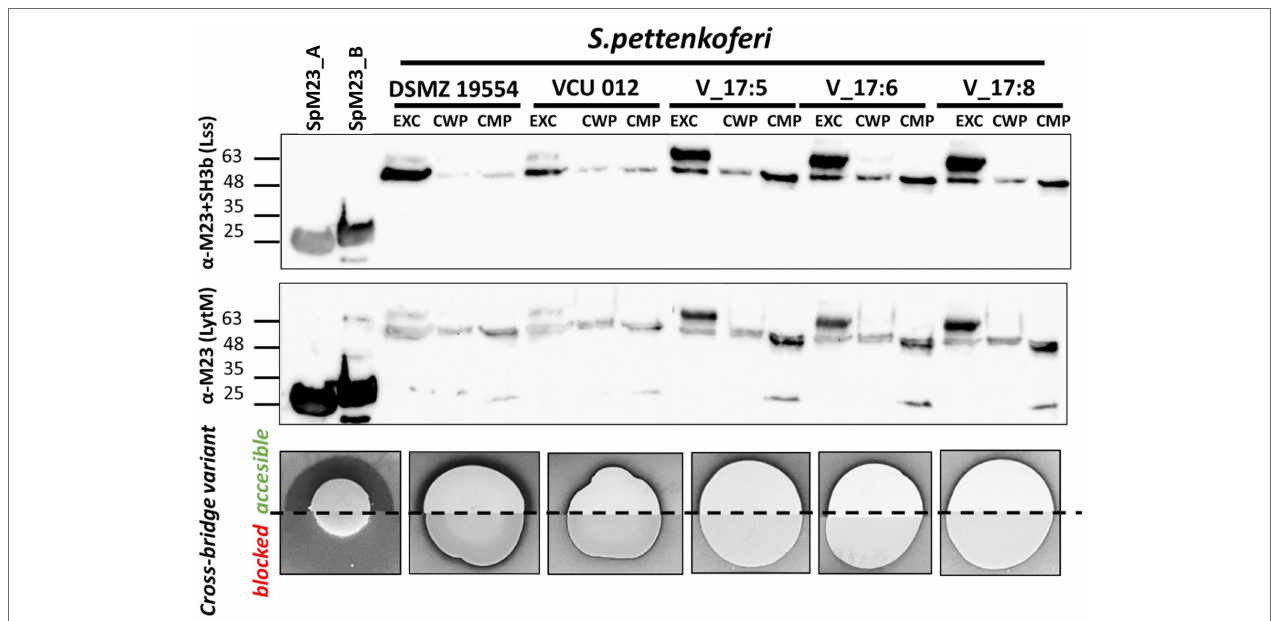
FIGURE 4 | SpM23_A is produced under native conditions. Western blot analysis showing the presence of the SpM23_A protein identified in Staphylococcus pettenkoferi strains. EXC: extracellular fraction (concentrated 25-fold); CWP: LiCl-extracted cell wall protein fraction (concentrated 100-fold); CMP: SDS-extracted cell membrane protein fraction (concentrated 100-fold). Bioactivity assay of SpM23_A produced by S. pettenkoferi strains or spotted solution of recombinant enzyme (0.1 μ g, positive control). A S. aureus Δ tagO lawn was used as the biomarker owing to its susceptibility to SpM23_A in conditions of high ionic strength, such as in TSB medium. For additional controls, see Supplementary Figure 6